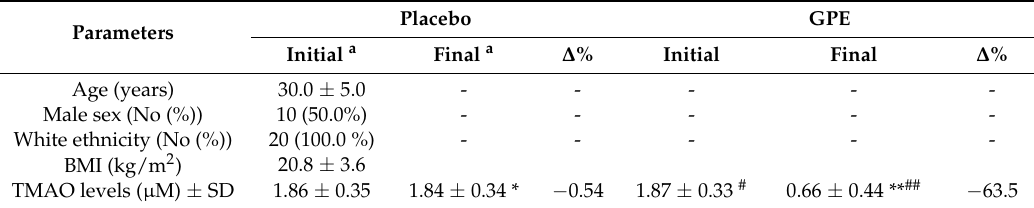
Table 3. Effects of Taurisolo ® on TMAO serum levels in healthy subjects ( n = 20).